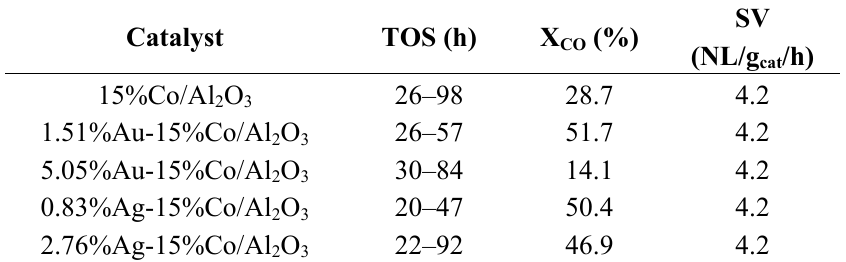
for two Ag and Au-promoted 15%Co/Al Table 3. X CO relative to to the unpromoted catalyst. Conditions: 220 °C, 1.6 MPa, H with permission from [10] Copyright 2009, Elsevier).